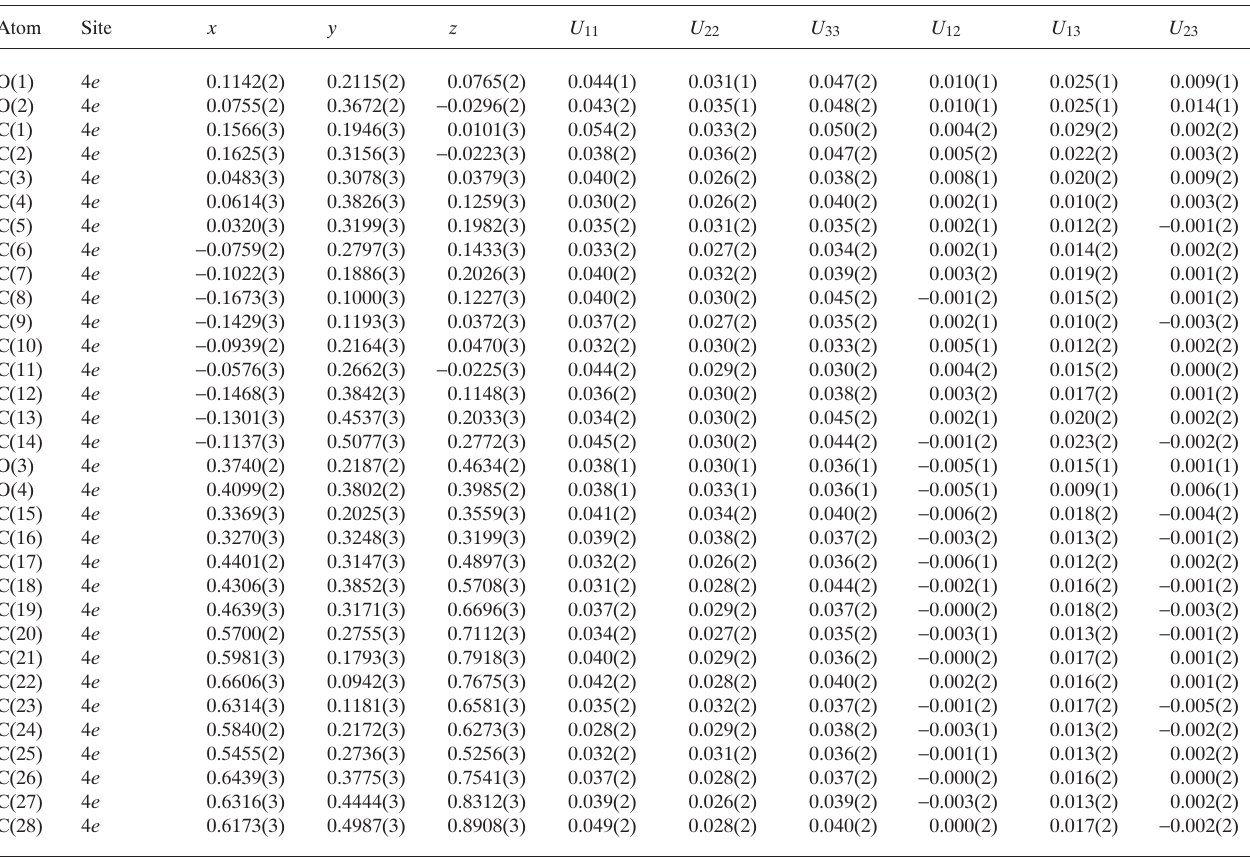
Table 3. Atomic coordinates and displacement parameters (in Å 2 )